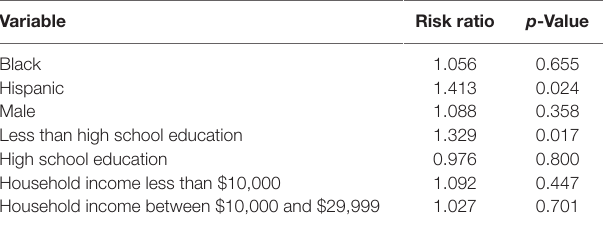
Table 2 | regression analyses for having a problem with the